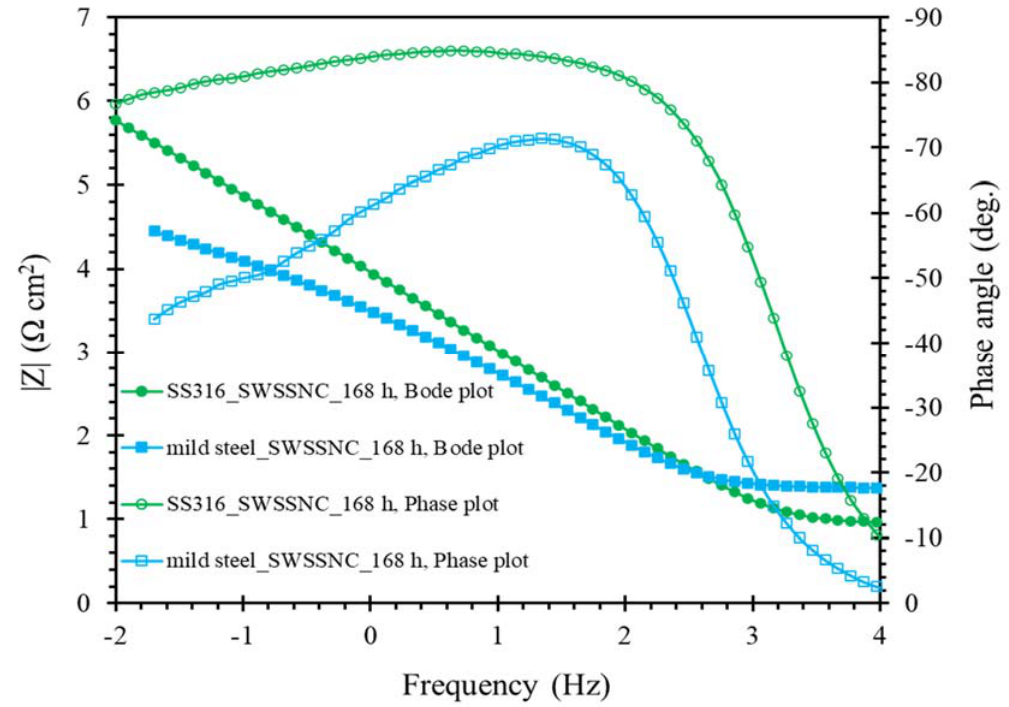
Figure A1. Bode plots and phase plots for mild steel and SS316 pre-immersed in SWSSNC for 168 h.